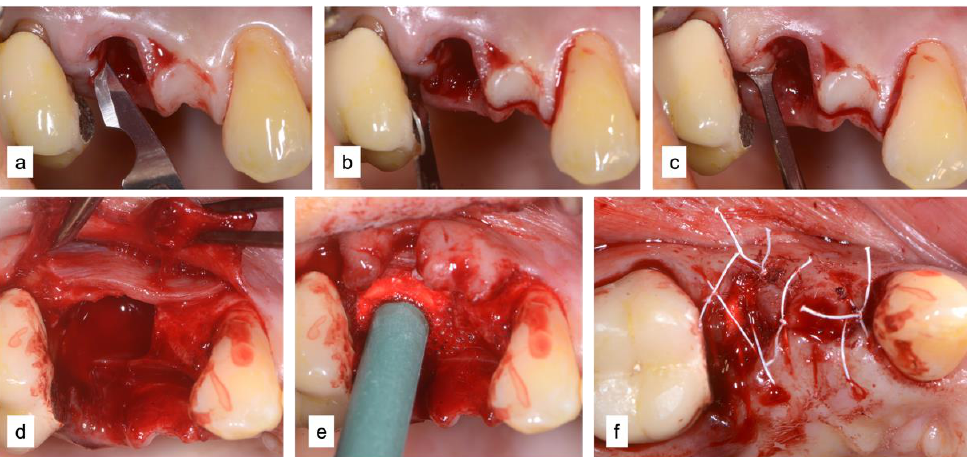
Figure 1. Surgical protocol: ( a , b ) intrasulcular incisions; ( c ) mucoperiosteal flap elevation; ( d ) OsteoBiol ® Lamina Soft (Tecnoss ® , Giaveno, Italy) was adapted to buccal bone; ( e ) Condress (Smith & Nephew S.r.l., Monza, Italy) insertion in the socket; ( f ) flap was closed with a cross suture, while the papilla was closed with two sling stitches.